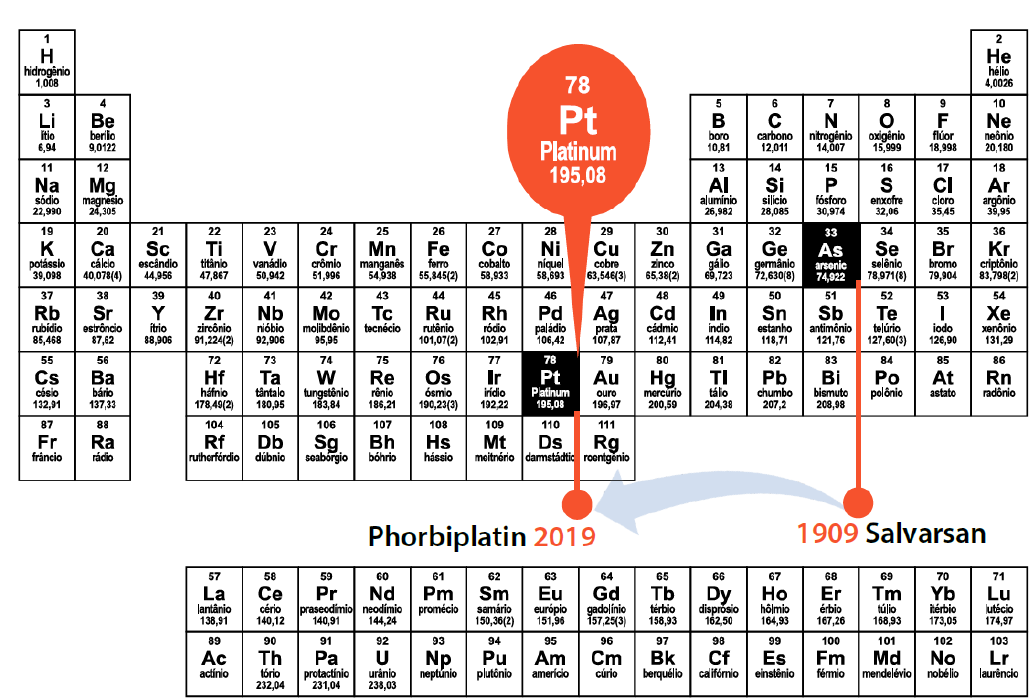
Figure 8. A spatial and temporal breakthrough with the discovery of phorbiplatin.